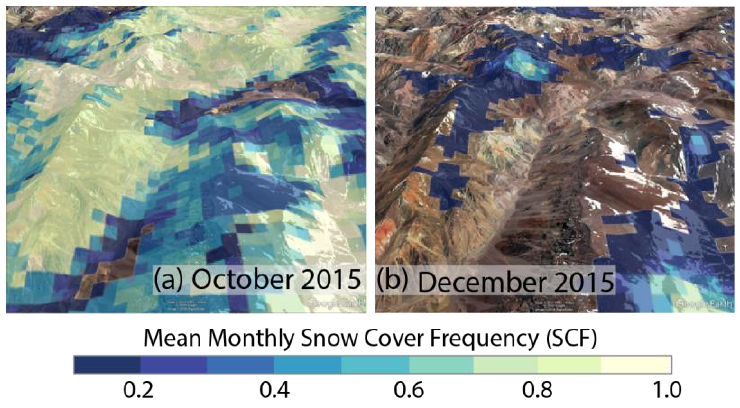
Figure 1. Maps of monthly snow cover frequency in the Chilean Andes (30 ° S, ranging in elevation from 3135 to 6200 m) for October ( a ; spring) and December ( b ; early summer) showing the extreme changes in seasonal snow.